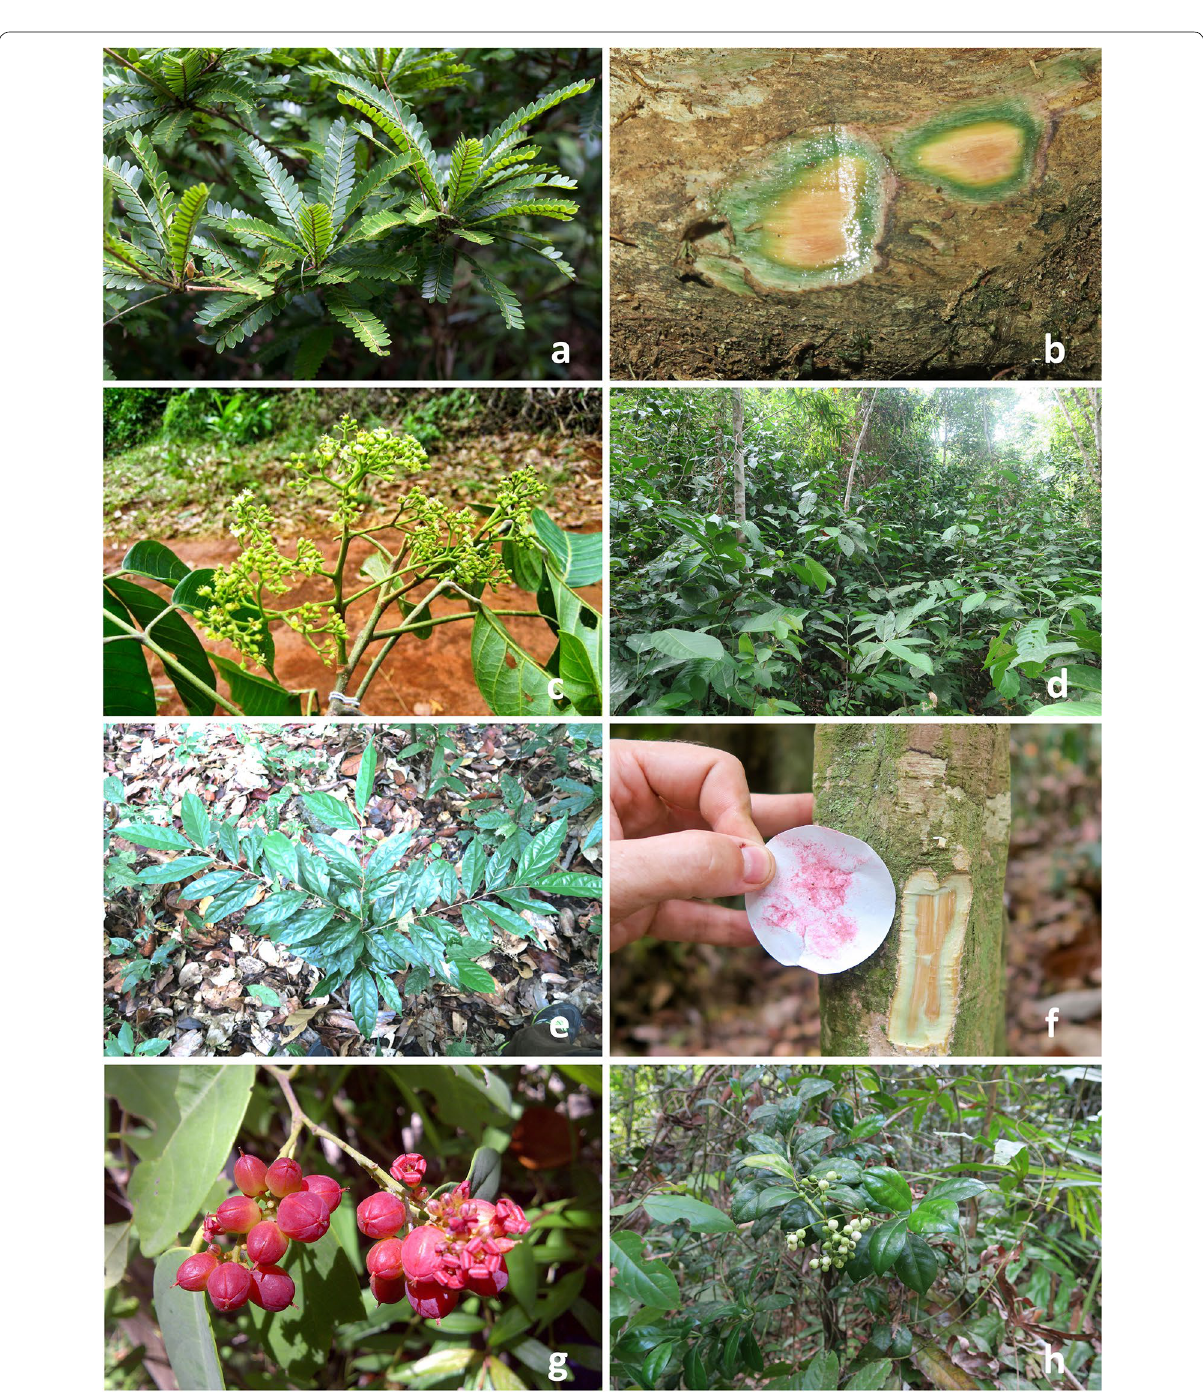
Fig. 3 Nickel hyperaccumulator plants in South and Southeast Asia: a Phyllanthus balgooyi (Phyllanthaceae) in Sabah, Malaysia is a small under- storey tree. b Phloem sap exuding from Phyllanthus balgooyi contains up to 20 wt% Ni. c Knema matanensis (Myristicaceae) in Sulawesi, Indonesia; d Rinorea bengalensis (Violaceae) can be locally dominant in lowland forest, in Sabah, Malaysia. e Dichapetalum gelonioides subsp. tuberculatum (Dichapetalaceae) from Mount Silam, Malaysia. f Main stem of Dichapetalum gelonioides subsp. tuberculatum showing its Ni-rich phloem tissue with colorimetric response in dimethylglyoxime test-paper. g Sarcotheca celebica (Oxalidaceae) from Sulawesi, Indonesia. h Psychotria sarmentosa (Rubiaceae) is the only known Ni hyperaccumulator in South and Southeast Asia that is a climber (all images are by A. van der Ent, except c , g are